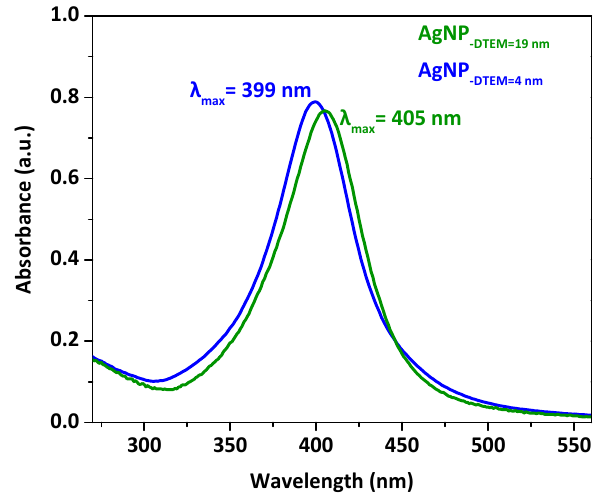
Figure 6. UV-Vis absorption spectra of PEI-coated, PVP-stabilized AgNP with average diameters of 19 nm (green) and 4 nm (blue), respectively.